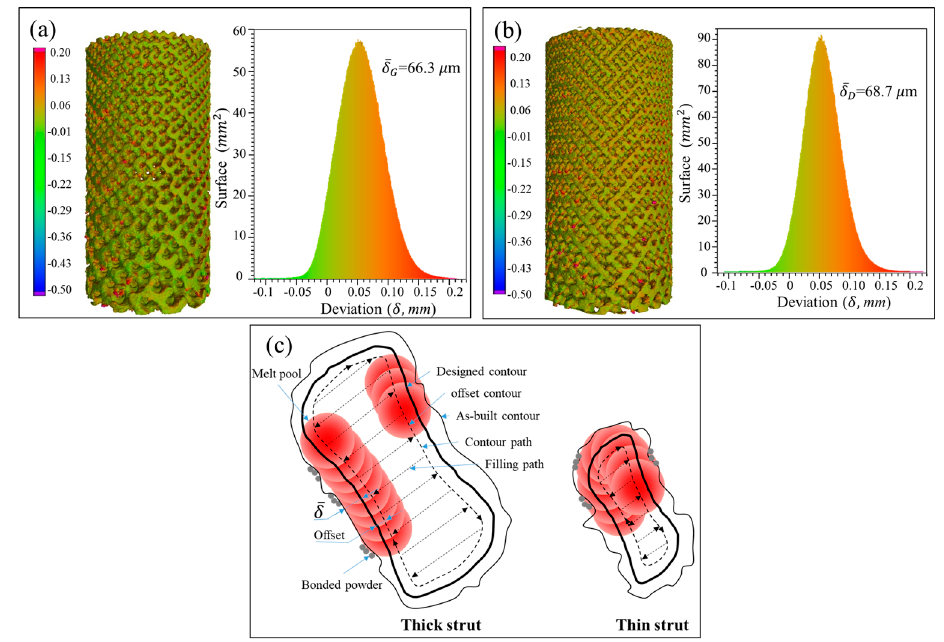
Figure 6. Statistical analysis of the deviation between designed and as-built parts for G ( a ) and D ( b ) structure, and ( c ) schematic diagram for the deviation of as-built parts.